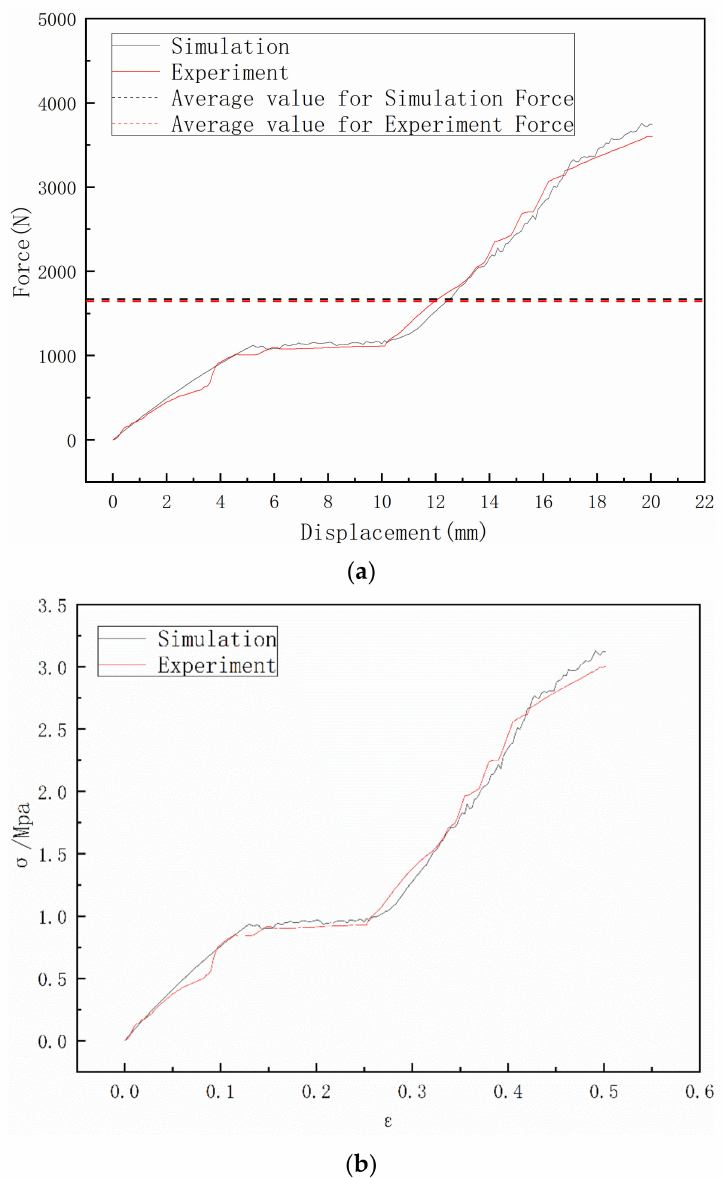
Figure 11. ( a ) Comparison of simulation results with experimental results. ( b ) Stress–strain curves of simulation results and experiment